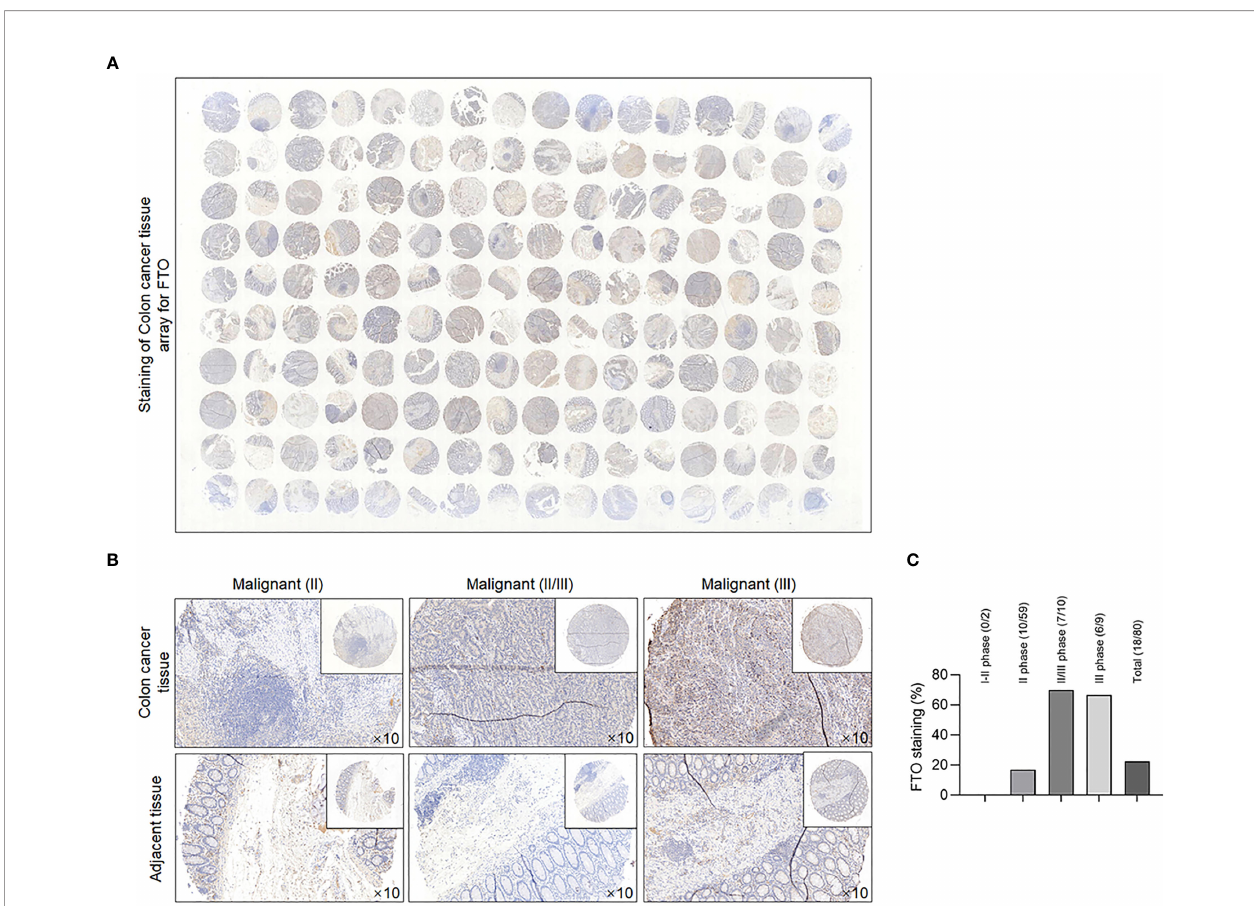
FIGURE 3 | FTO expression was identi fi ed in clinical COAD patients. (A) Clinical COAD tissue microarray assay was analyzed by IHC with anti-FTO antibody, and full scan of tissue microarray is shown as indicated. (B) Representative images of FTO staining under high power fi eld (HPF) from clinical COAD tissue microarray. (C) Qualitative analysis for expression pattern and stained grade of FTO in clinical COAD tissue